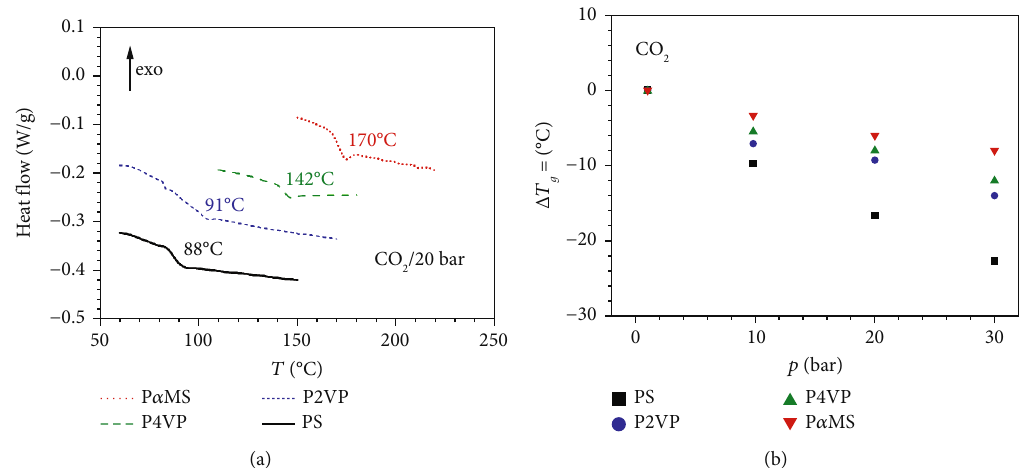
Figure 7: Results of di ff erential scanning calorimetry measurements at elevated pressure. (a) HP-DSC data at a pressure of 20 bar. (b) of glass transition temperature T as a function of pressure p . The curves of heat fl ow are shifted vertically for clarity. Reduction Δ T g g